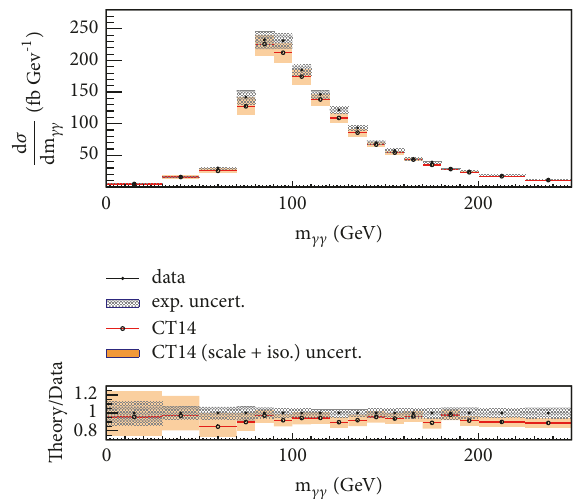
Figure 4: The MATRIX differential fiducial cross-section related to CT14 as a function of 𝑚 𝛾𝛾 compared to the data [9], in the range 0 < 𝑚 < 250 𝛾𝛾